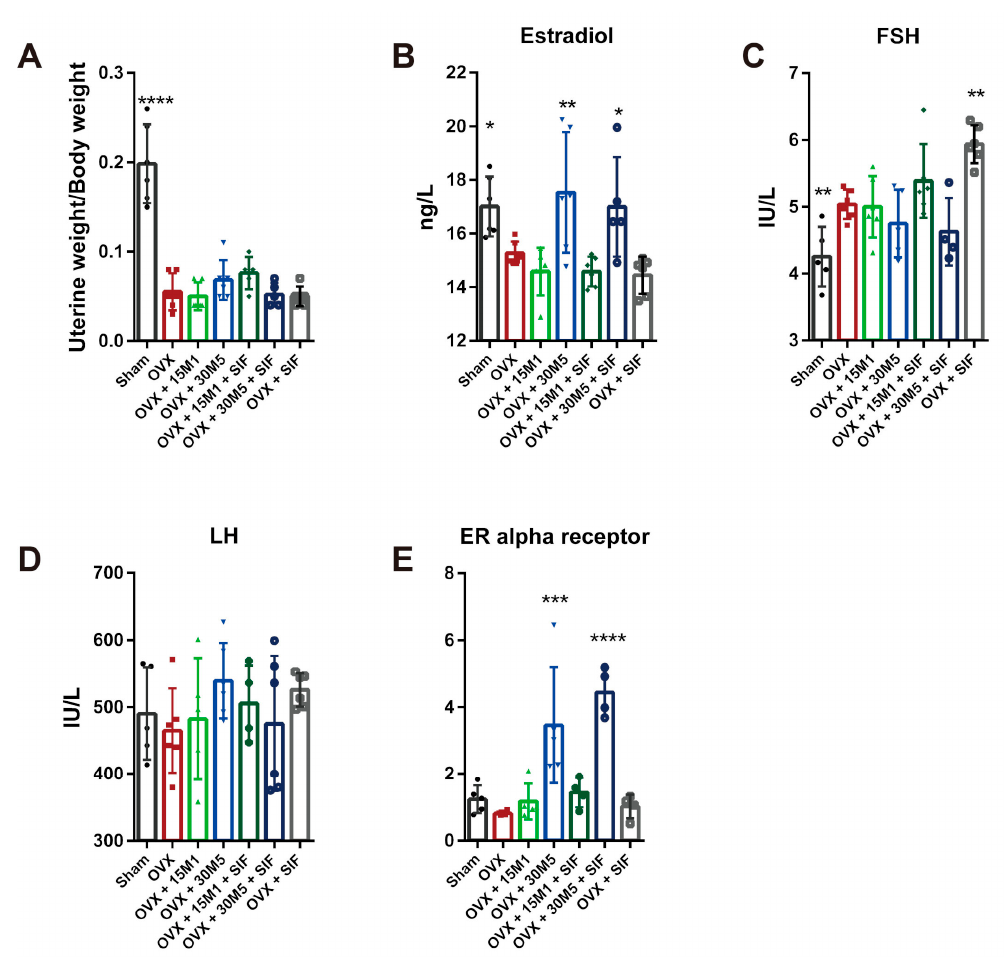
Figure 4. L. plantarum 30M5 changes sex hormone levels and up-regulates estrogen receptors. ( A ) Severe atrophy of the uterus in OVX mice. ( B ) Estradiol in serum significantly increased by L. plantarum 30M5. ( C ) Follicle-stimulating hormone (FSH) in serum significantly decreased by ovariectomy. ( D ) The level of serum luteinizing hormone (LH). ( E ) The expression of Estrogen Receptor (ER) α in abdominal adipose tissue up-regulated by L. plantarum 30M5. * p < 0.05, ** p < 0.01, *** p < 0.001 compared with the OVX group. Data present as the means ± SD. Significant difference between study groups were evaluated using ordinary one-way analysis of variance (ANOVA) and uncorrected Fisher’s LSD multiple comparison test.